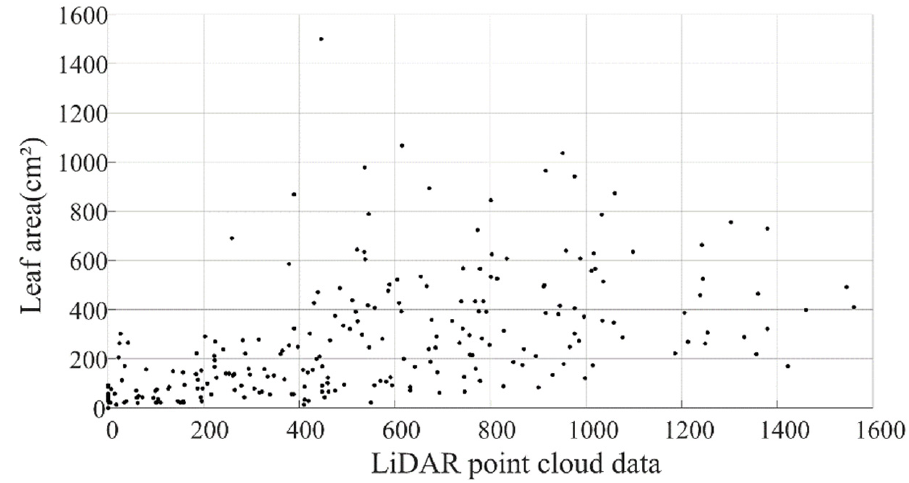
Figure 5. Original LiDAR point cloud data and leaf areas.